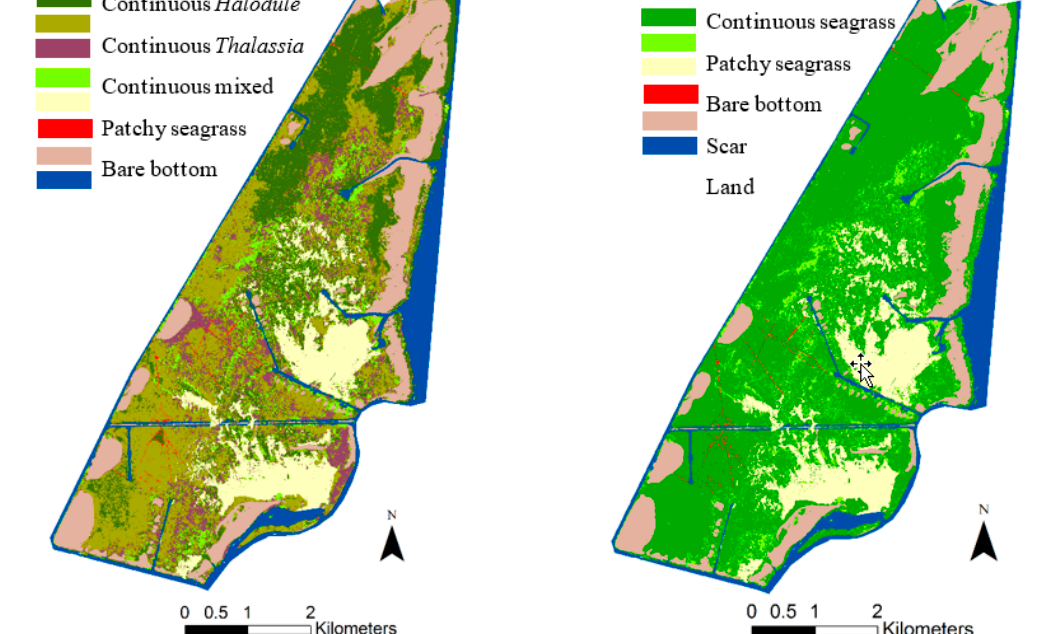
Figure 4. The 5-class map ( left ) and 3-class map ( right ) of seagrass in the Redfish Bay,